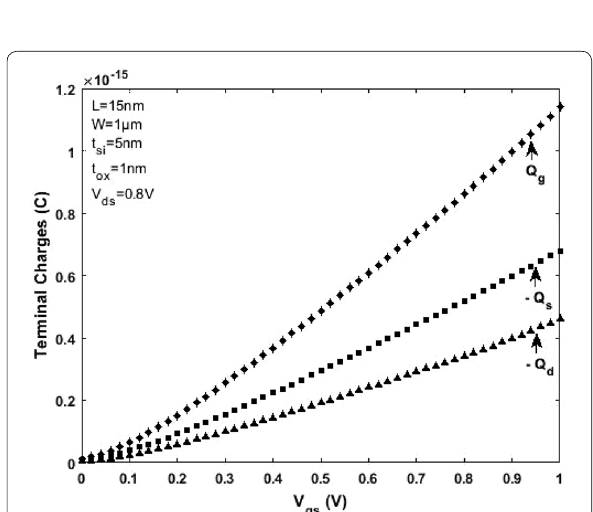
Fig. 9 Variation of terminal charges as a function of gate voltage V gs represented by different symbols. Q g ,Q d and Q s represent gate, drain and source charge